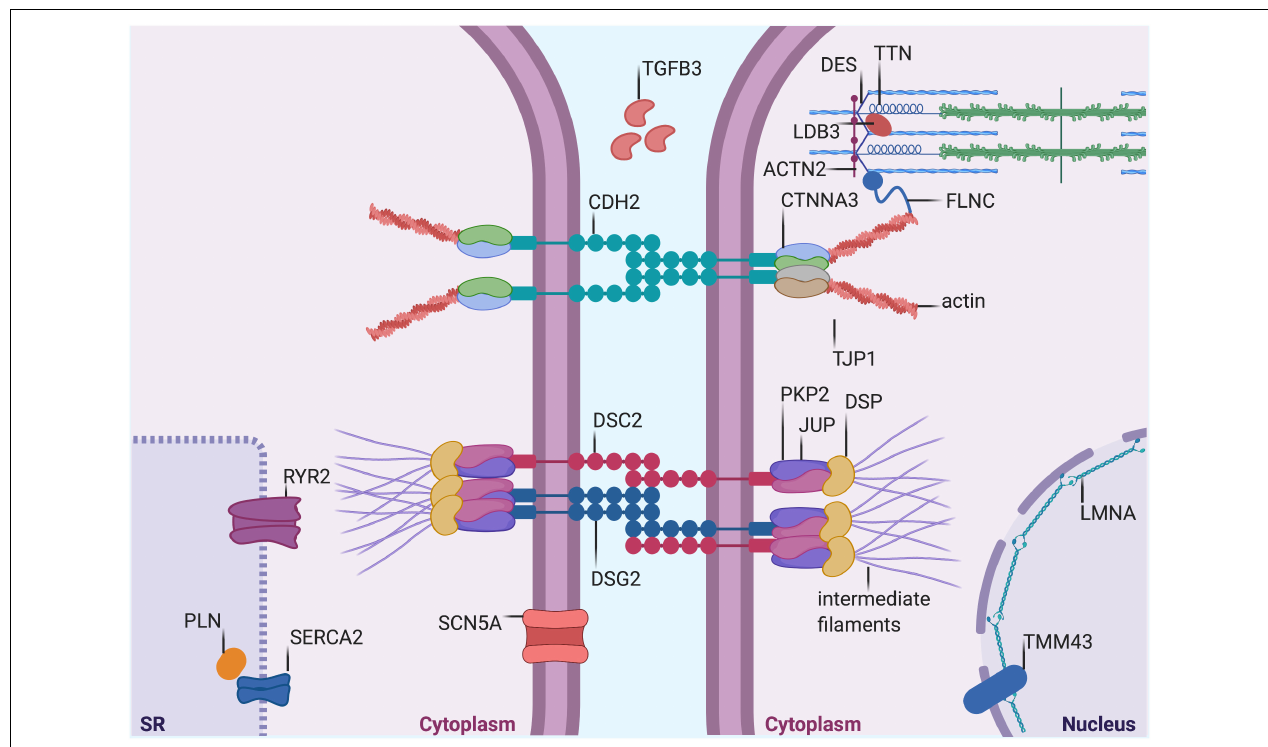
FIGURE 1 | Proteins mutated in AC. Graphical representation of proteins that are mutated in AC. Both proteins desmosomal (see Table 1 ) and non-desmosomal proteins (see Table 2 ) are depicted in this figure. DSP, desmoplakin; PKP2, plakophilin-2; DSG2, desmoglein-2; DSC2, desmocollin-2; JUP, plakoglobin; CTNNA3, α -T-Catenin; CDH2, cadherin-2; TJP1, tight Junction Protein ZO-1; DES, desmin; TTN, titin; FLMN, filamin C; LMNA, lamin A/C; TMEM43, transmembrane protein-43; ACTN2, α -actinin-2; LDB3, lim domain binding 3 or ZASP; RYR2, ryanodine Receptor-2; PLN, phospholamban; TGF β 3, transforming growth factor β 3; and SCN5A, sodium voltage-gated channel alpha subunit 5. SERCA2, sarcoplasmic/endoplasmic reticulum calcium ATPase 2. The figure was redrawn from Austin et al.,